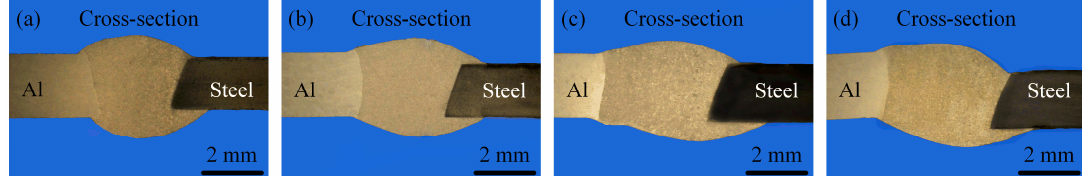
Figure 5. Effects of laser power on the weld shape:; ( a ) 1.9 kW; ( b ) 2.0kW; ( c ) 2.1 kW; ( d ) 2.2 kW.